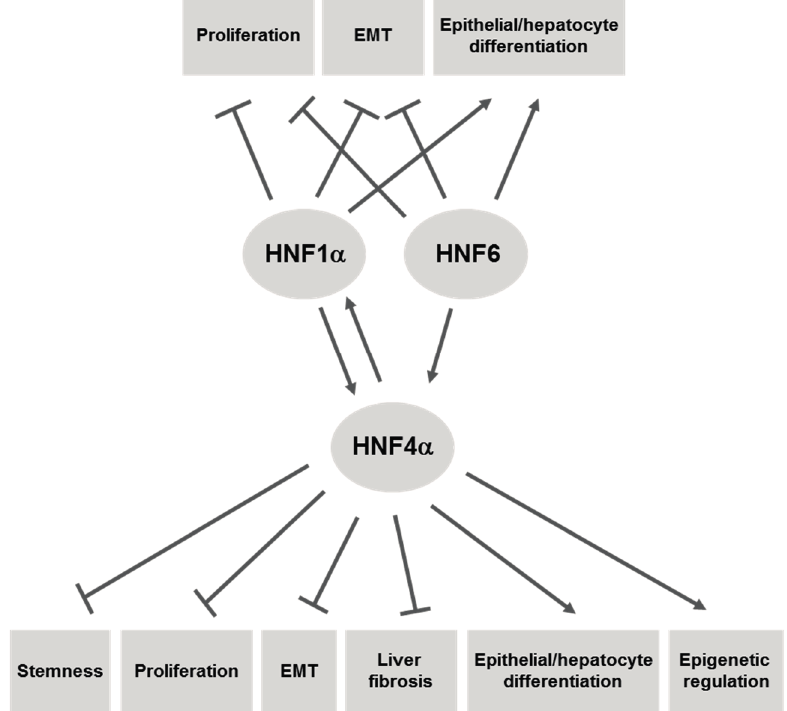
Figure 1. Tumor suppressor properties of HNF4 α , HNF1 α , and HNF6 in HCCs. HNFs can regulate different cell functions associated with the HCC onset and progression, through the direct transcriptional activation/repression of target genes (described in the text). The reciprocal regulation among HNFs is